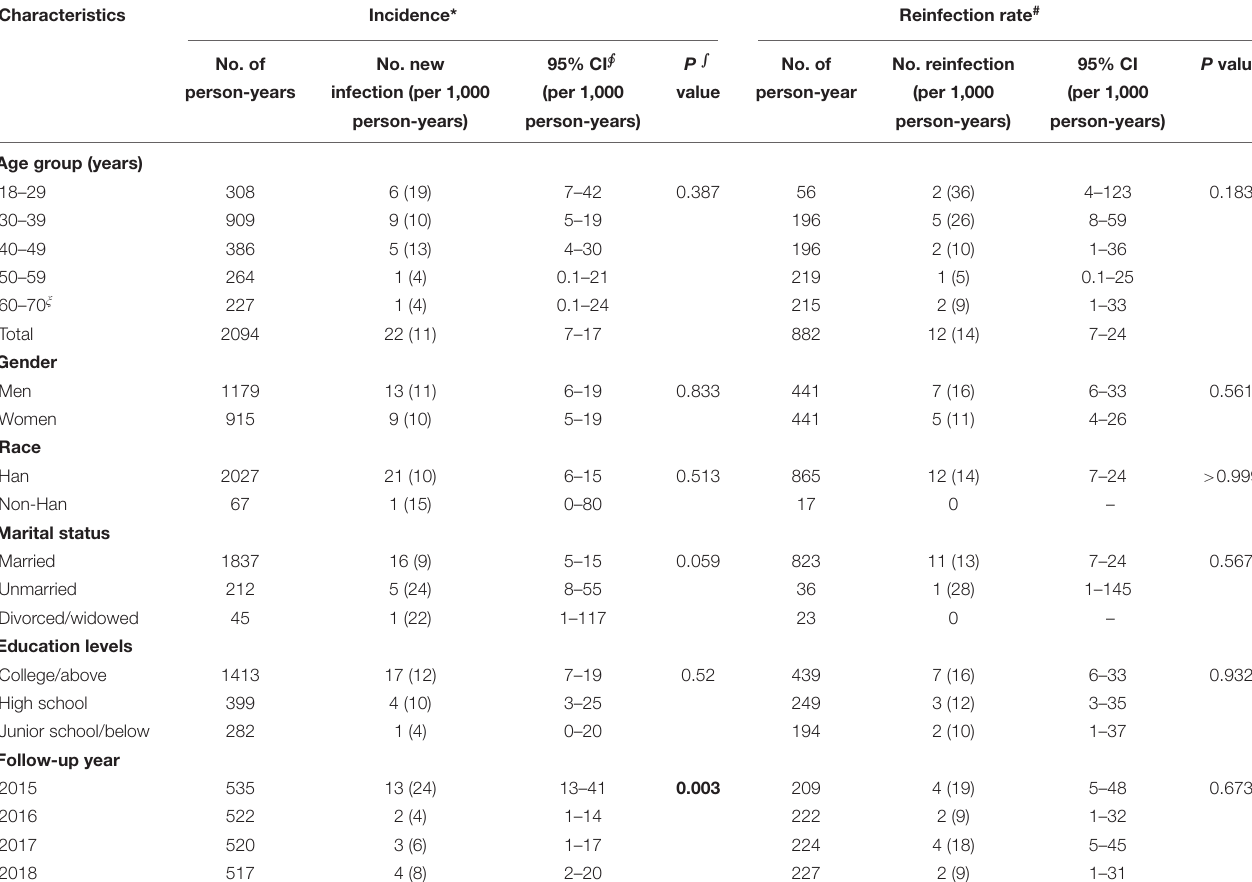
TABLE 4 | Incidence and reinfection rate of C. trachomatis infection in a community population of Northern China during 2014 and 2018.